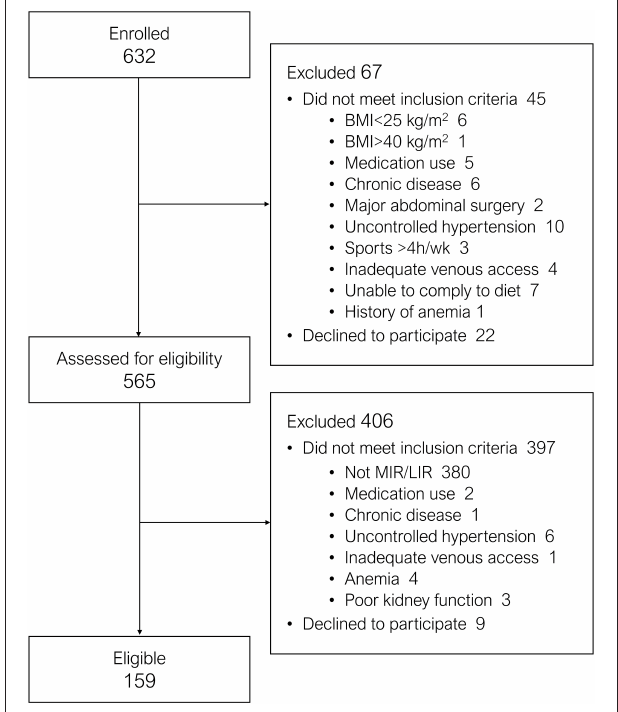
FIGURE 5 | Flowchart of participant enrollment and eligibility from March 2018 to March